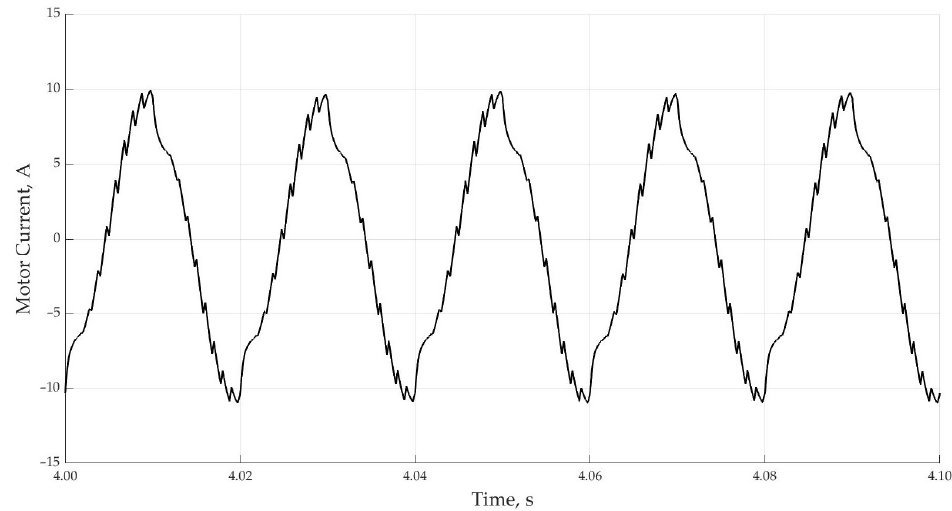
Figure A1. Motor current waveform for case of using relay controller with all zones disabled.